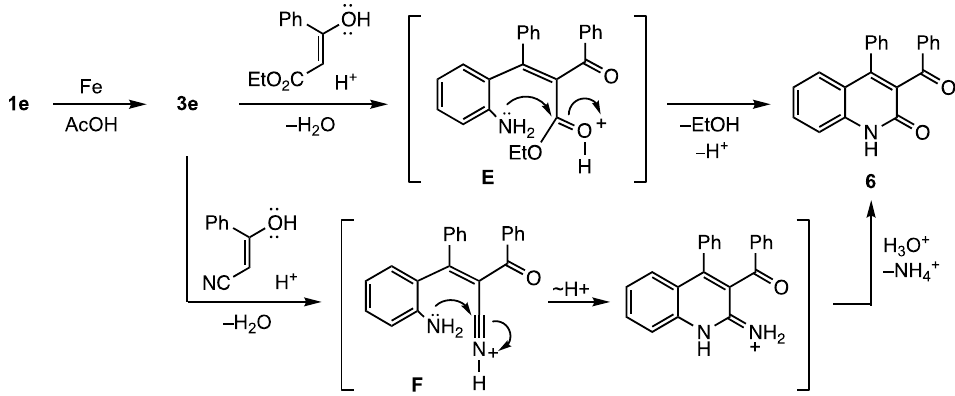
Table 1. Domino nitro reduction-Friedländer reaction using 2-nitrobenzaldehyde ( 1a